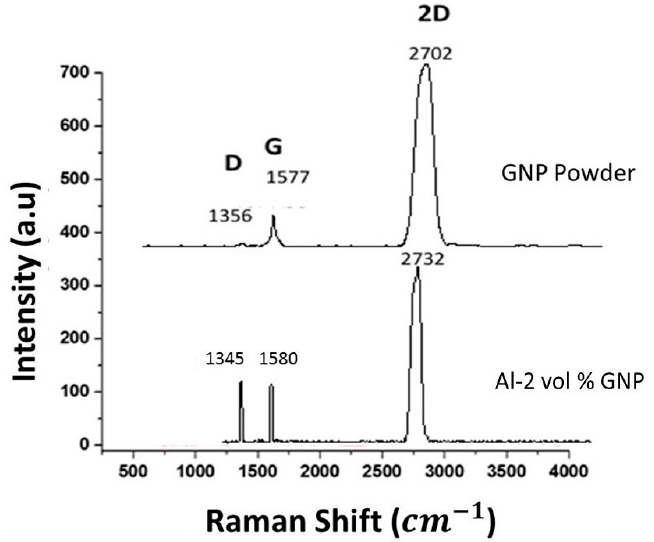
Figure 4. Raman scattering spectrum of the as-received GNP and sintered Al-2 vol % GNP pellets.